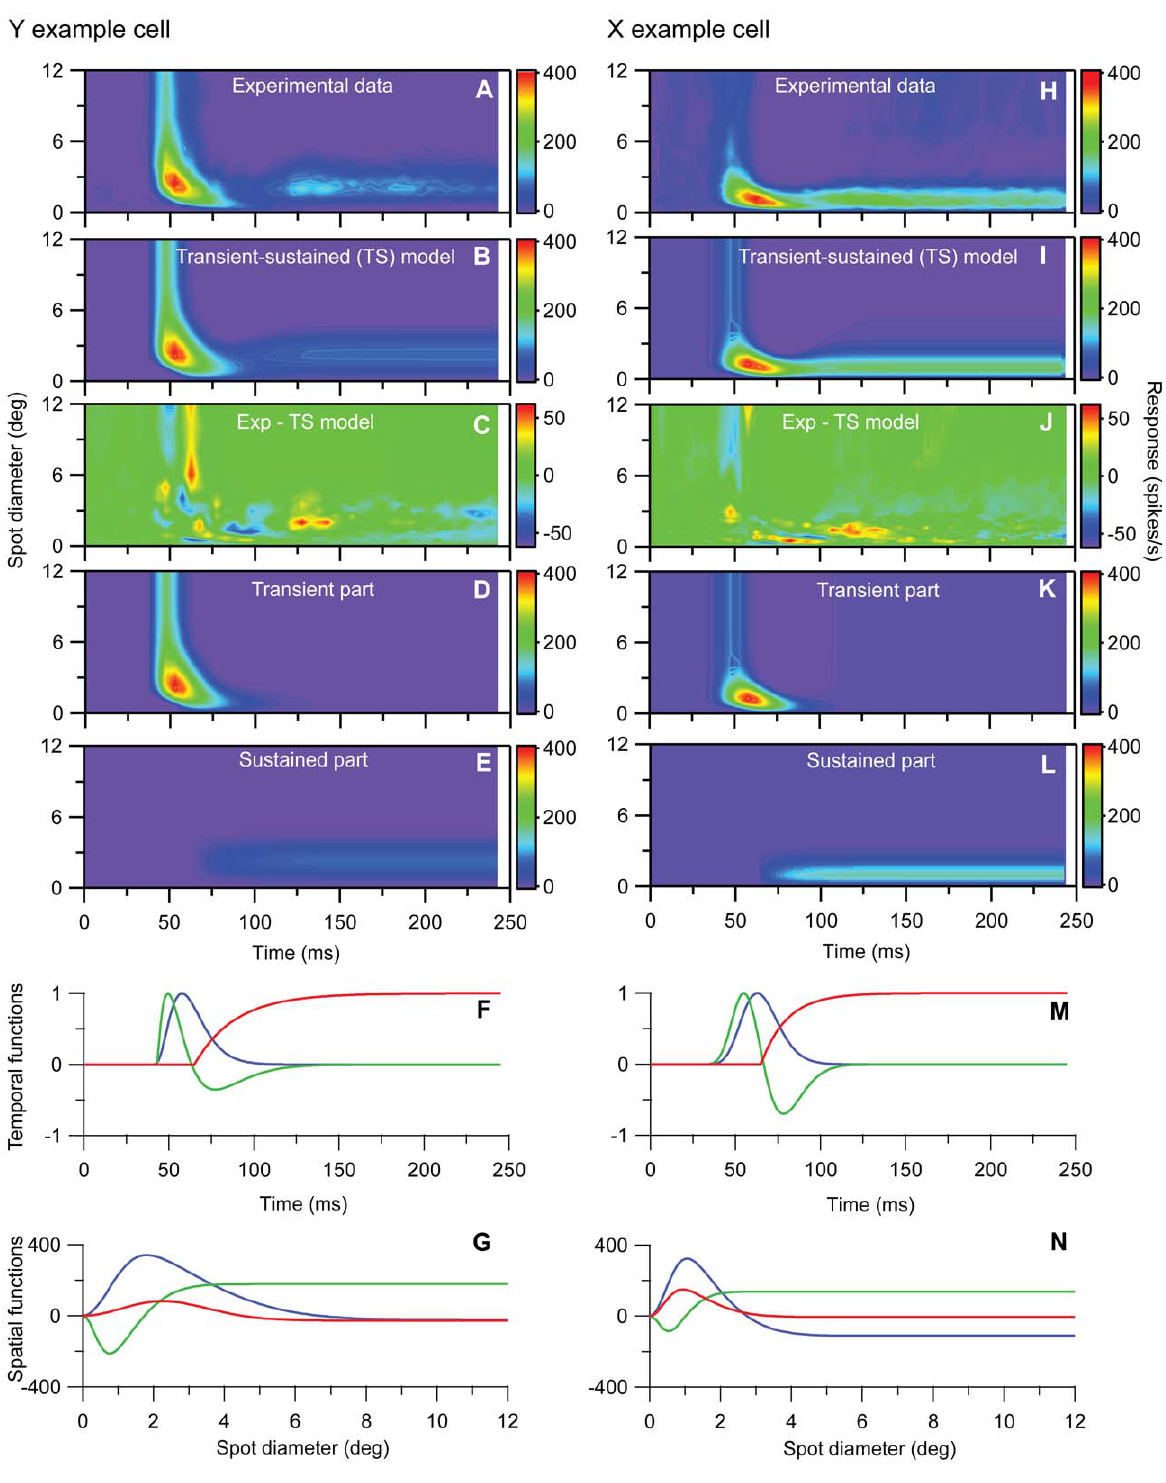
Figure 10. Fits to transient-sustained (TS) model for example on-center Y and X neurons in Figs. 1 and 2. A , Experimental Y-neuron response data. B , Best fit to TS model in Eq. (14). C , Deviation between experimental results (A) and model results in (B). Error e (cf. Eq. 1) is 0.029. D , Transient component only, i.e., R ( t,d )=[R bkg + F t1 ( t ) G t1 ( d ) + F t2 (t ) G t2 ( d ))] + . E , Sustained component only, i.e., R ( t,d )=[R bkg + F s ( t ) G s ( d )] + . F , Fitted transient temporal functions F t1 ( t ) (Eq. 11,blue line) and F t2 ( t ) (Eq. 12, green line), and sustained temporal function F s ( t ) (Eq. 13, red line) for Y-neuron. G , Fitted transient spatial functions G t1 ( d ) (blue line) and G t2 ( d ) (green line), and sustained spatial function G s ( d ) (red line) for Y-neuron. All spatial functions are modeled as DOGs, cf. Eq. (10). H–N , Same as (A)–(G) for the X-neuron response data. The deviation between experimental results (H) and model results (I) corresponds to an error e =0.022. The fitted parameter values from both fits are listed in Table 1.